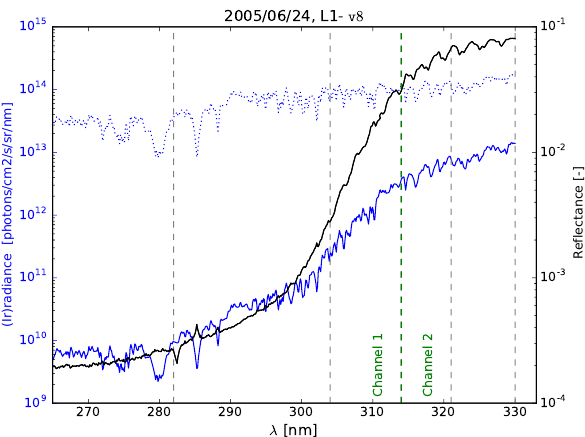
Figure 1. Example of SCIAMACHY spectra used for ozone pro- file retrieval: Earth radiance (solid blue line) and solar irradiance (dotted blue line) in photonscm − 2 s − 1 sr − 1 nm − 1 , and reflectance (solid black line) (unit-less). The vertical dashed line in green sepa- rates the two channels and the vertical grey lines separate the clus- ters listed in Table